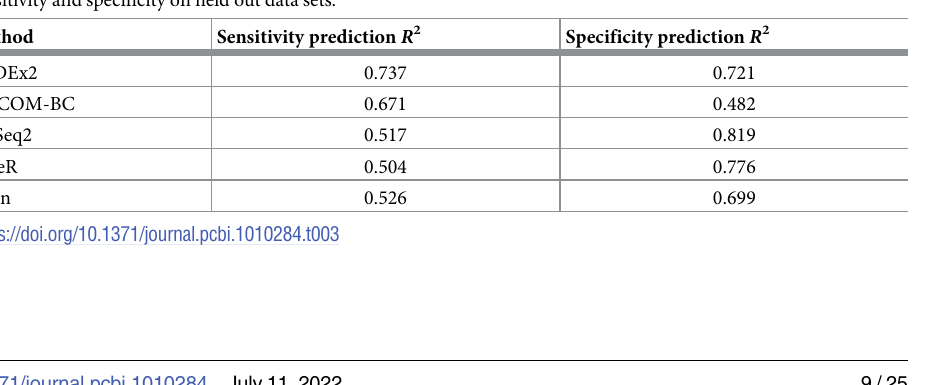
Table 3. Predictive model performance summaries. Performance of per-method random forest predictive models of sensitivity and specificity on held out data